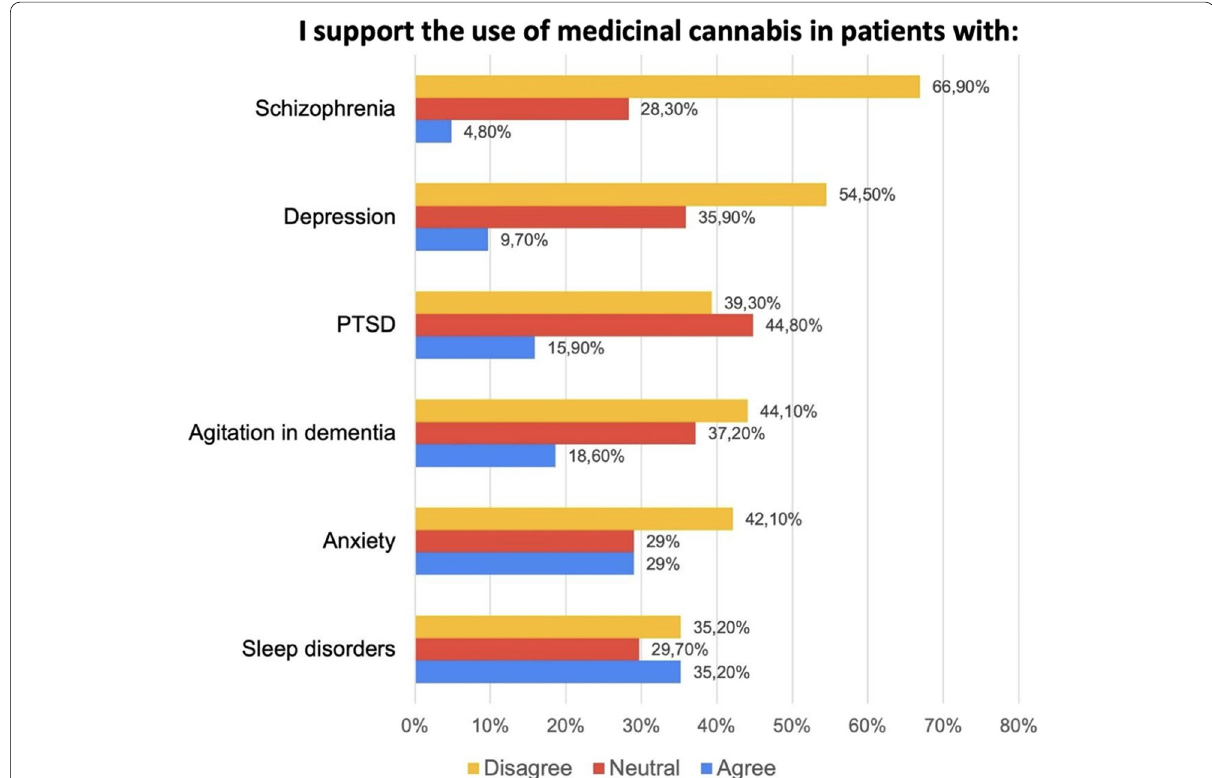
Fig. 2 Support for use of medicinal cannabis in different mental health conditions among 145 Colombian psychiatrists. The mental health condition with the highest approval for the use of MC was sleep disorders and the one with the most disapproval was schizophrenia. MC, medicinal